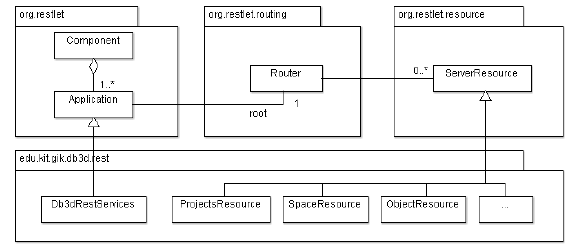
Figure 1: Class diagram showing implementation aspects of DB4GeO’s REST-based framework